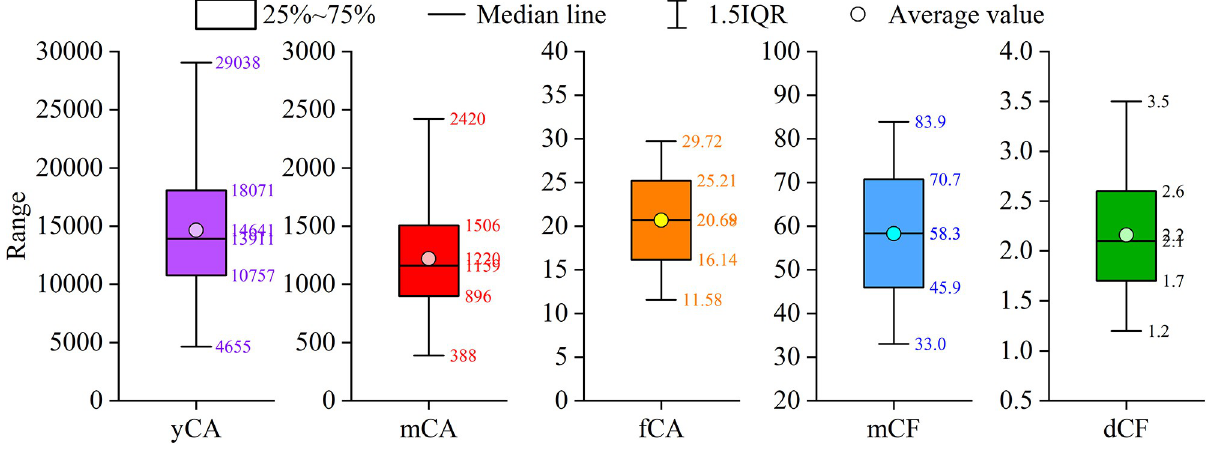
Fig 4. Distribution of the five quantified descriptive